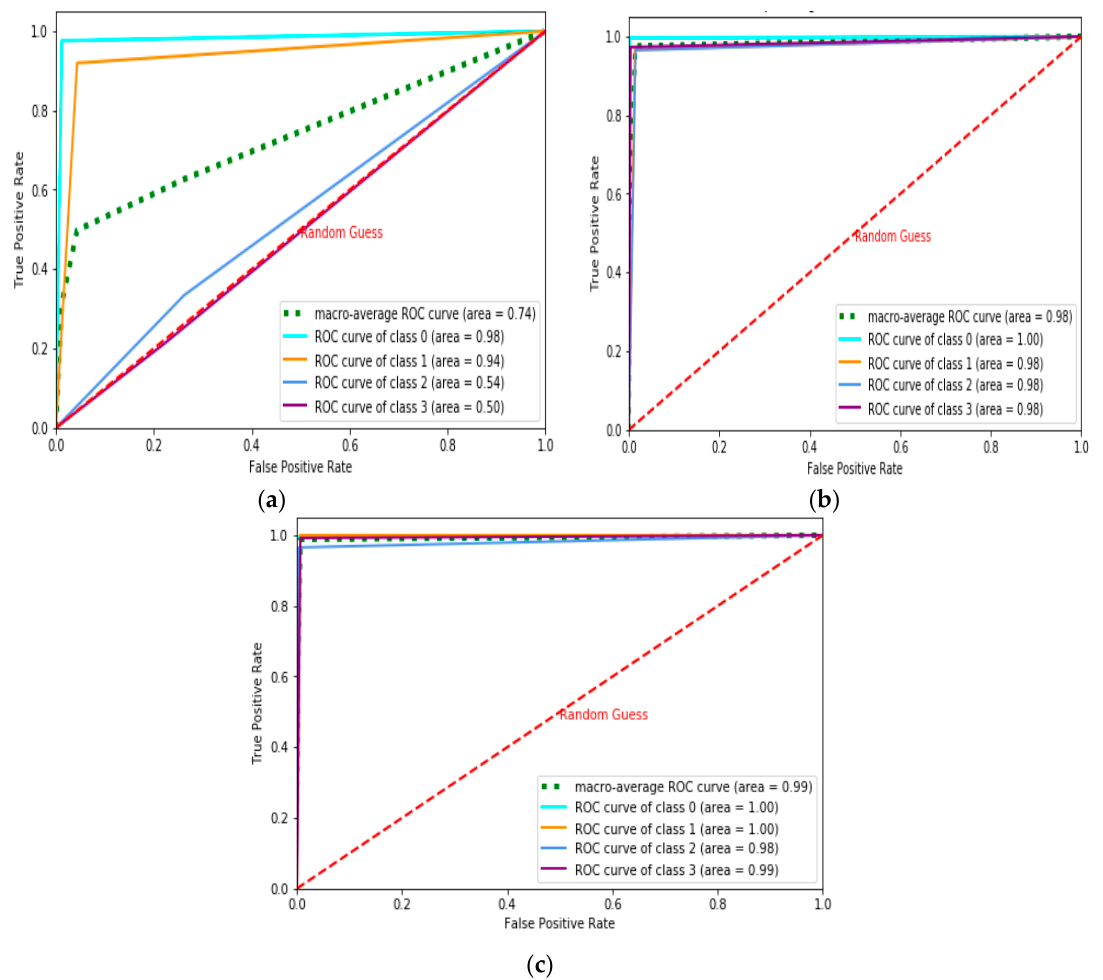
Figure 2. Multiclass Area Under Curve (AUC)-Receiver Operating Characteristics (ROC) curve for Neural Network (NN) model for: ( a ) N h = 30, ( b ) N h = 50, ( c ) N h = 80. ( N h − Number of hidden neurons )